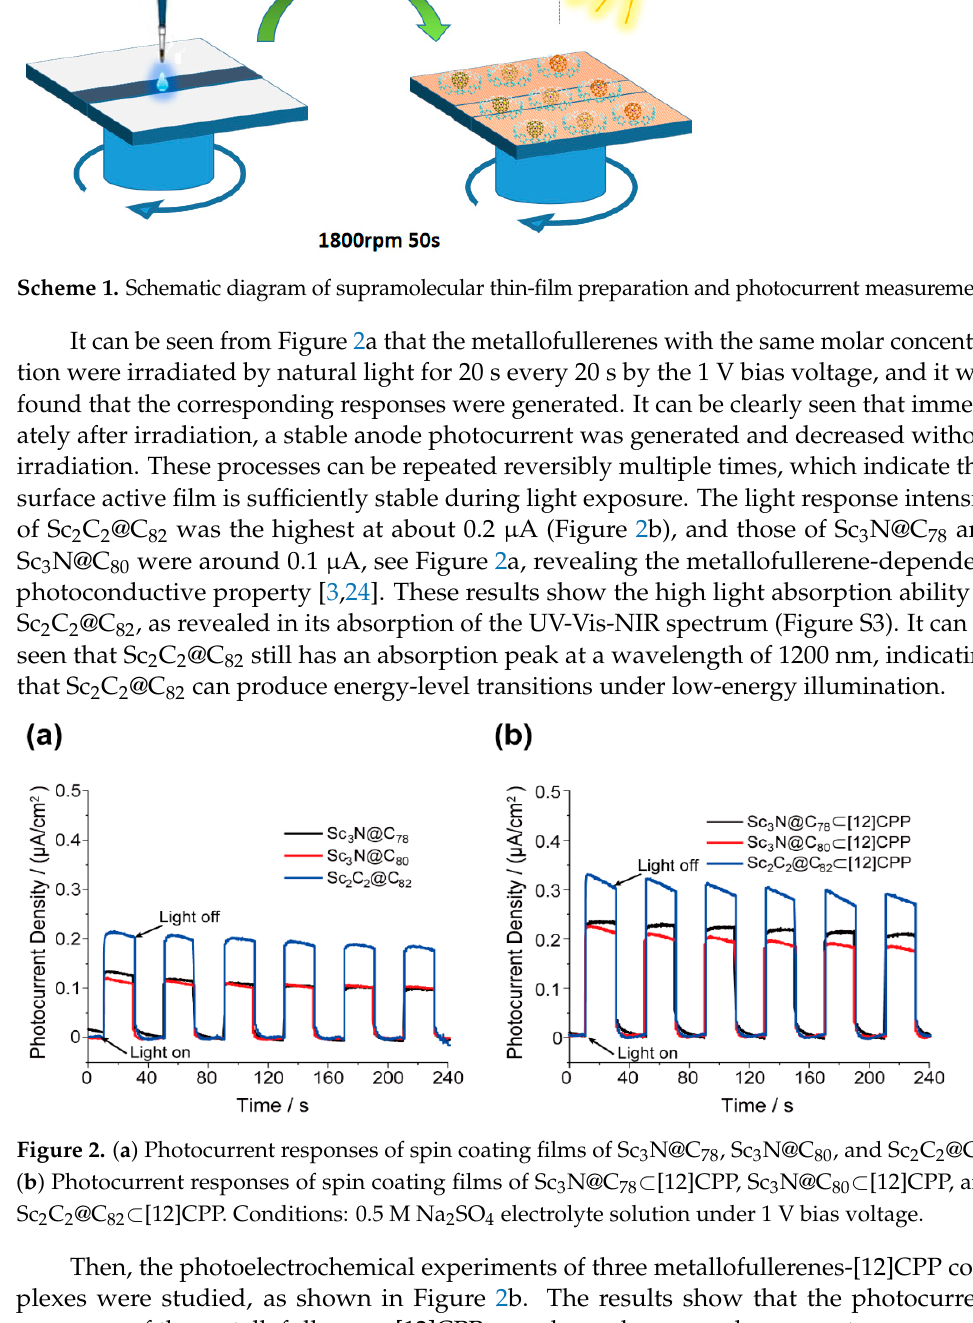
Figure 2. ( a ) Photocurrent responses of spin coating films of Sc 3 N@C 78 , Sc 3 N@C 80 , and Sc 2 C 2 @C 82 . ( b )